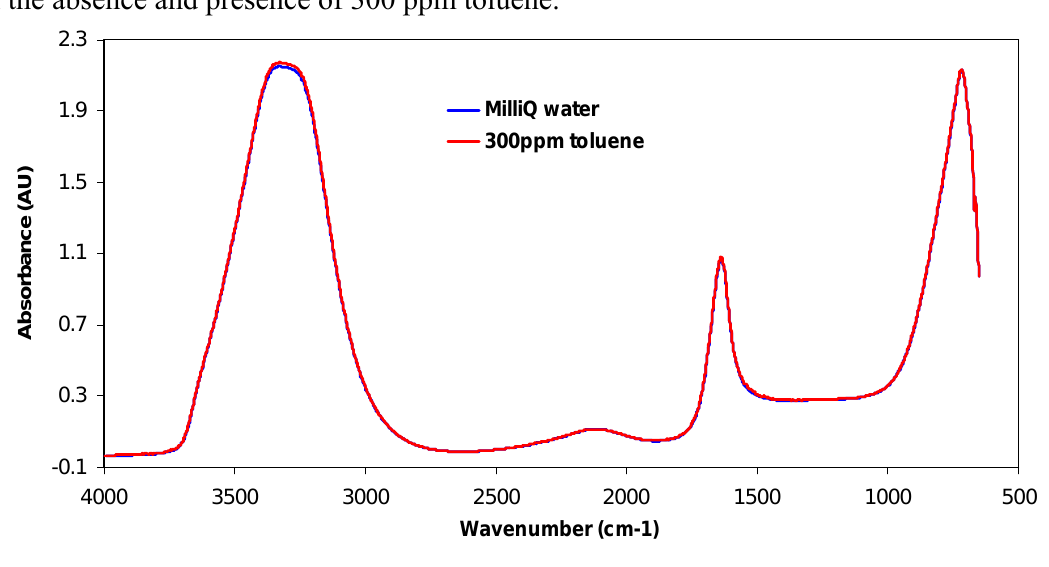
Figure 2. Comparison of the mid-infrared spectra of a ZnSe IRE exposed to MilliQ water in the absence and presence of 300 ppm